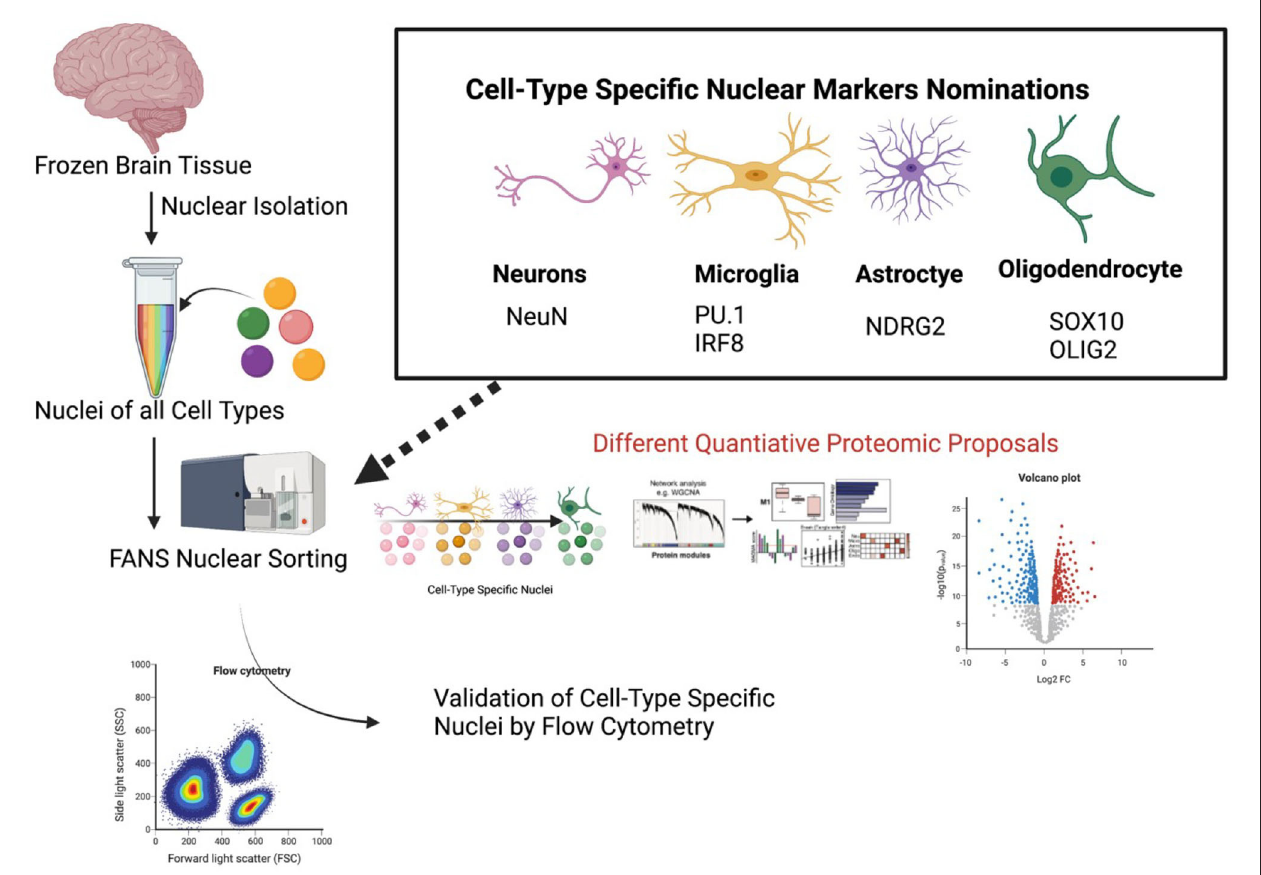
FIGURE 4 | A proposed pipeline for cell type-specific nuclear proteomics of human brain. Proposed specific cell-type specific nuclear markers for flow cytometry are listed. A proposed workflow for nuclear proteomics is also outlined once nuclei have been